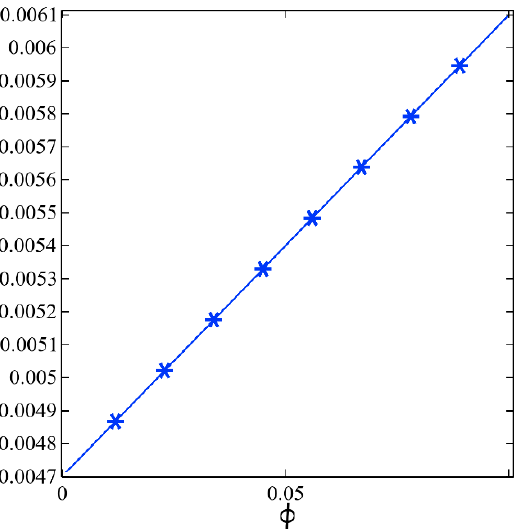
Figure 7. The increasing mass of the nanofluid and volume fraction of the outer cylinder.